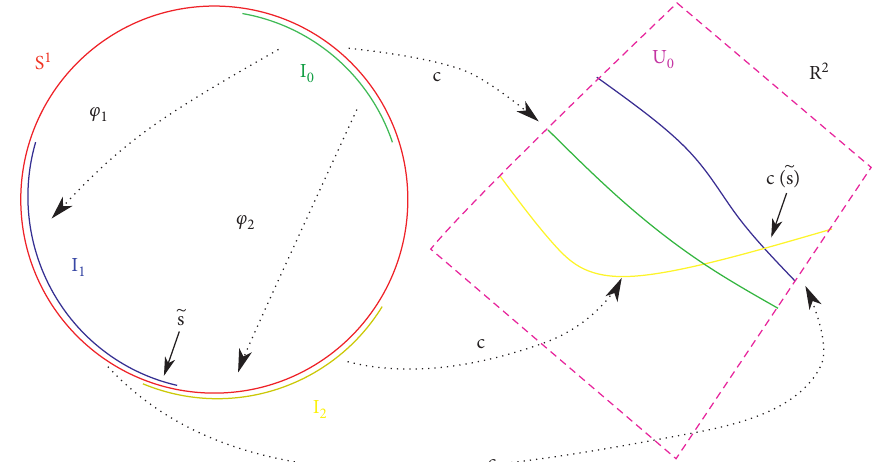
Figure 11: Helper scheme for proof of Lemma